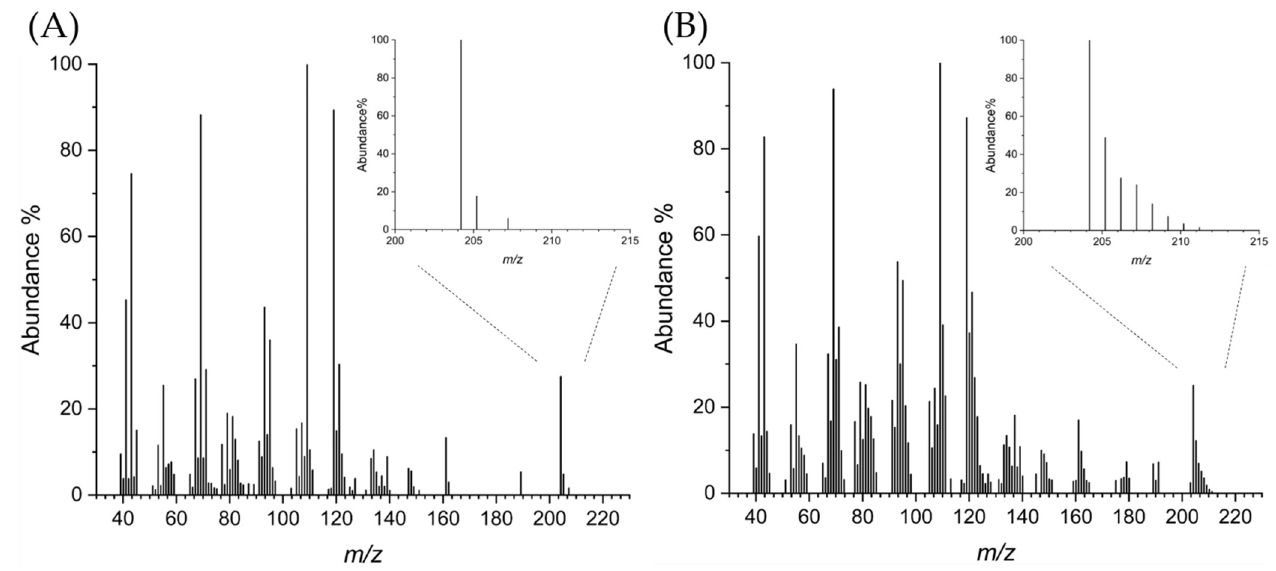
Figure 6. Mass spectra of α ‐ bisabolol. ( A ) Spectrum of α ‐ bisabolol (scan m / z from 33 to 300). ( B ) Spectrum of α ‐ bisabolol after supplementation of 13 C ‐ labeled acetate (scan m / z from 33 to 300). m / z range from 200 to 215 is shown superimposed in the upper right corner of the respective spectra.